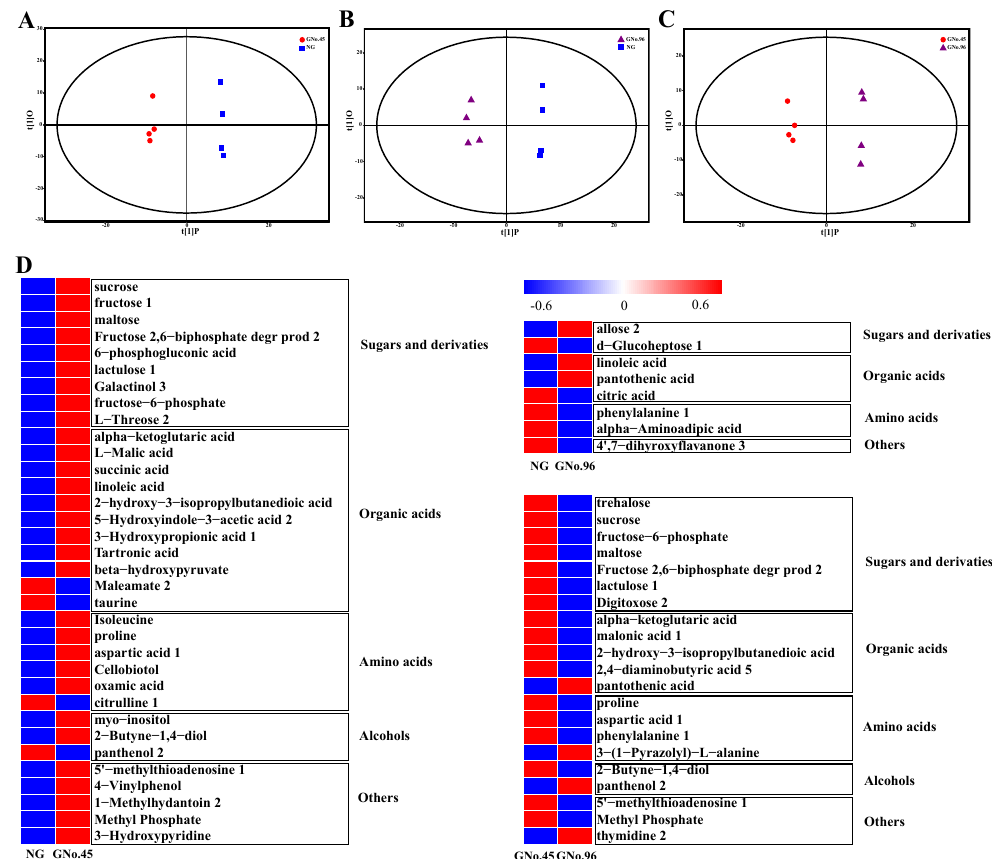
Figure 3. ( A ) OPLS-DA score plots generated from OPLS-DA models and di ff erent metabolites (DMs) in the cucumber fruit of NG, GNo.96, and GNo.45. ( B ) OPLS score plots (R2Y = 0.98; Q2 = 0.35). OPLS score plots (R2Y = 0.98; Q2 = 0.12). ( C ) OPLS score plots (R2Y = 0.98; Q2 = 0.27). ( D ) Heat maps of the contents of DMs in sugars and derivatives, organic acids, amino acids, alcohols, and others in fruits of NG, GNo.96, and